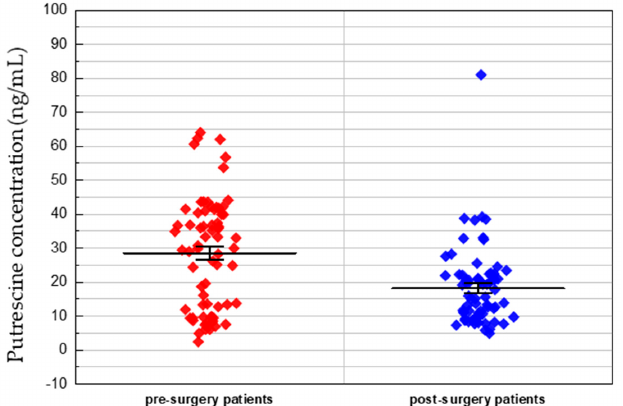
Figure 4. Putrescine concentration in pre- and post-operative patients with colorectal cancer. Each data point represents a patient’s individual putrescine concentration.